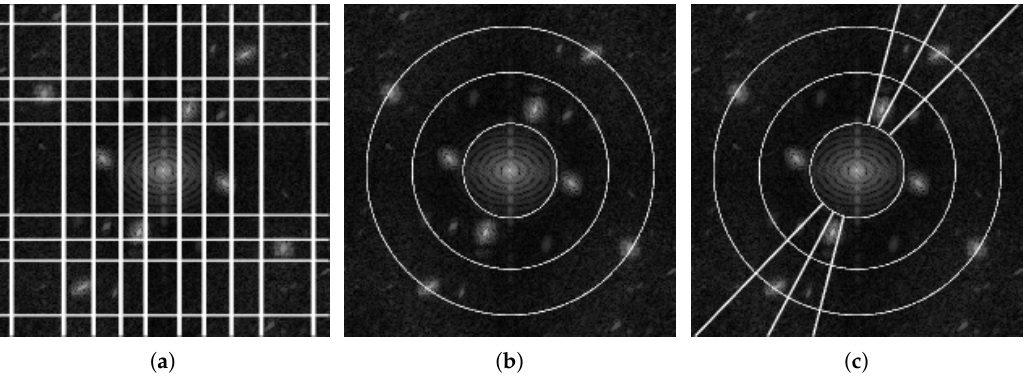
Figure 2. Examples of 2D EWT Implementations: In order from left to right, we see the partitioning of the Fourier spectrum of the ( a ) Tensor, ( b ) Littlewood–Paley, and ( c ) Curvelet (Option 1) empirical wavelet